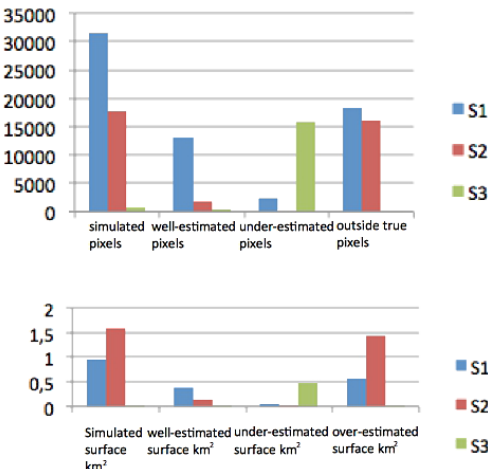
Figure 9. Influence of the DEM used for the simulation of the 2010 lava flow of Nyamulagira. (S1, S2, and S3 simulations correspond- ing, respectively, to SRTM1, SRTM3, and ASTER